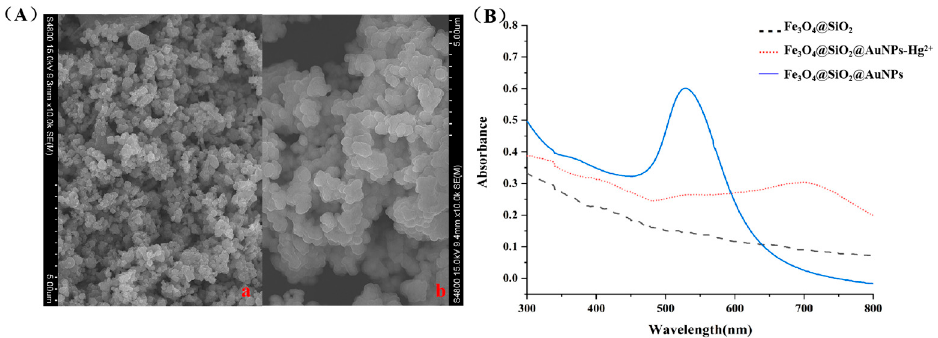
Figure 1. Characterization of Fe 3 O 4 @SiO 2 . ( A ) Scanning electron microscopy (SEM), the shape of uncoated Fe 3 O 4 particles ( a ), the shape of Fe 3 O 4 @SiO 2 after coating ( b ); ( B ) ultraviolet–visible spectroscopy (UV-Vis).